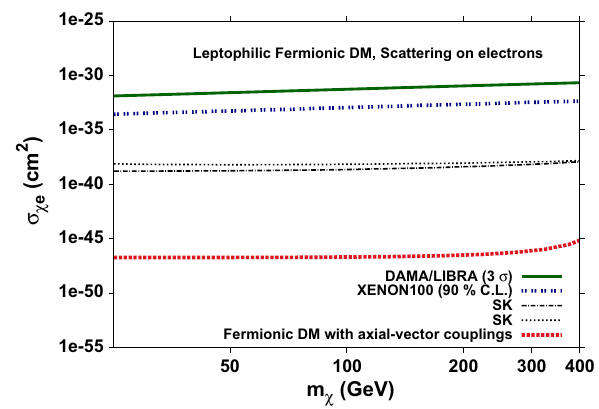
are obtained using micrOmegas – v –3 . 5 . 5 [47], the regions below the curves are allowed by the relic density bounds = α l = α l = α l = 1.Thesecurves PP SS VV V A